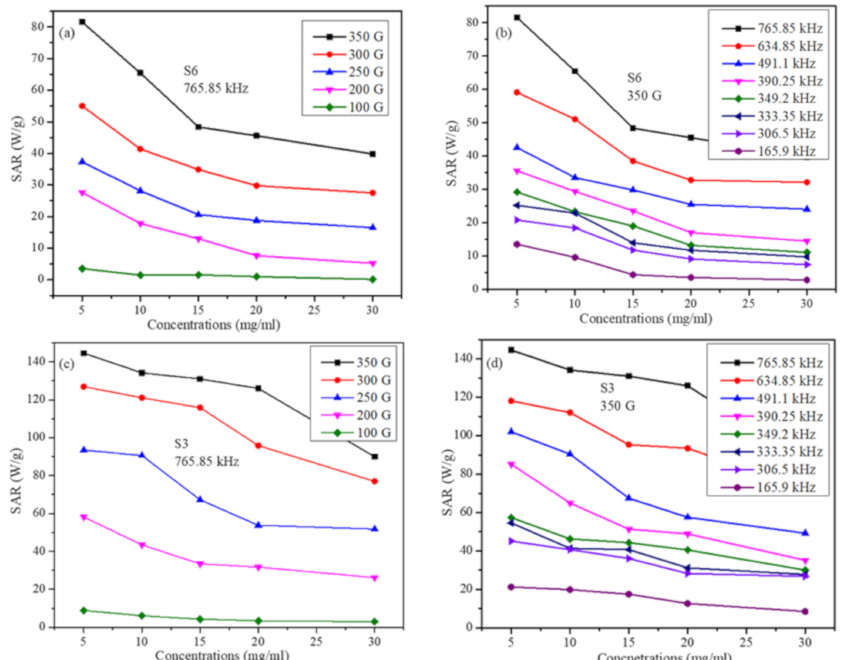
Figure 7. SAR values as a function of the particle concentration ( a ) for S6 sample at a fixed frequency for several field strengths, ( b ) for S6 sample at fixed field strength for several frequencies, ( c ) for S3 sample at a fixed frequency for several field strengths ( d ) for S3 sample at fixed field strength for several frequencies (lines in figures are just to guide the eye).